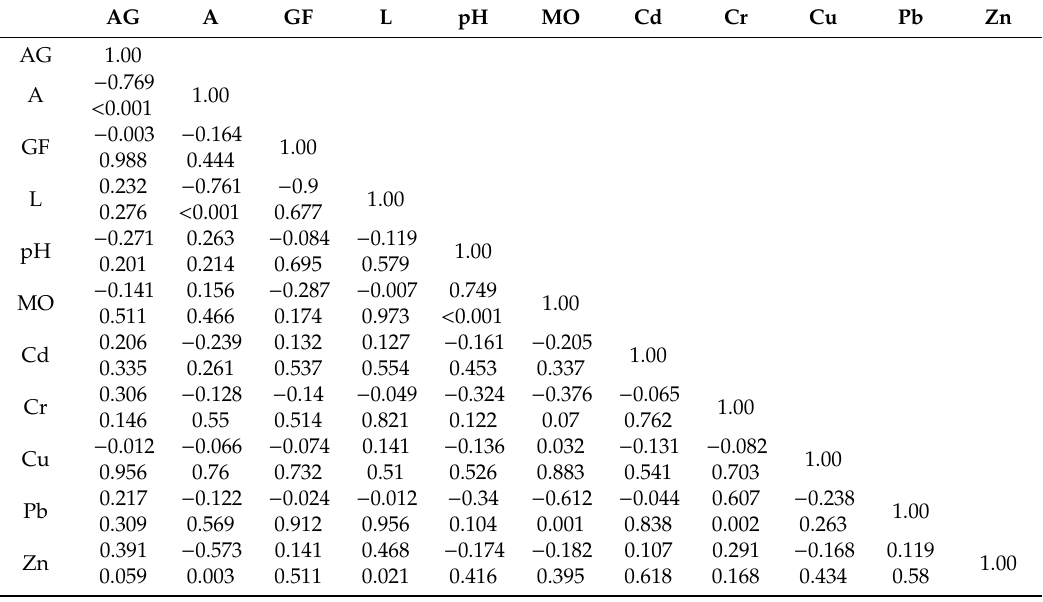
Table 2. Pearson correlation coe ffi cient and P value among the variables reported in the study.